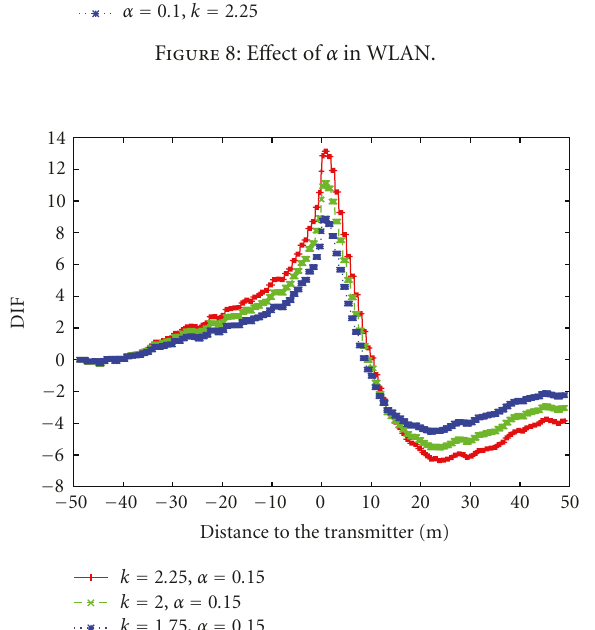
Figure 11: E ff ect of α and k in